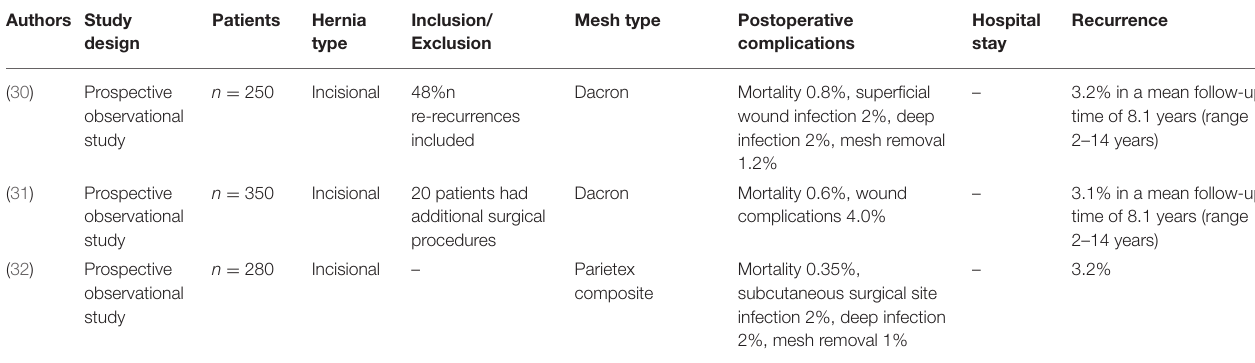
TABLE 3 | Open intraperitoneal onlay mesh with defect closure by a myoaponeurotic flap for incisional hernia repair. Authors Study design